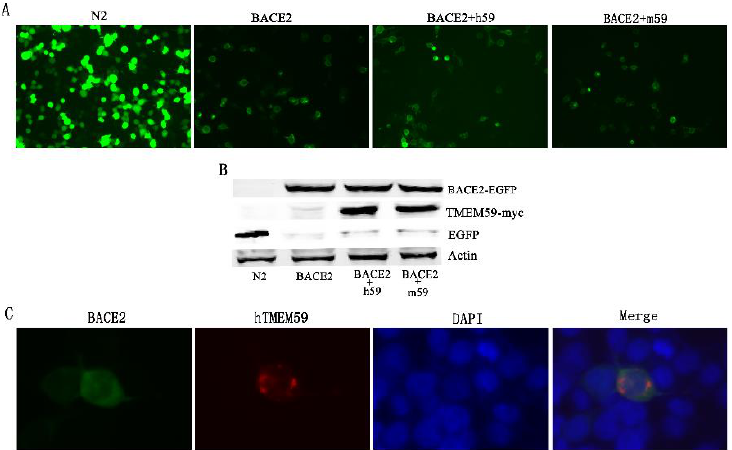
Figure 6. TMEM59 does not affect BACE2 protein expression. ( A ) TMEM59 did not change the localization of BACE2 in HEK293T cells. ( B ) The BACE2 protein level was not affected by TMEM59 in HEK293T cells. ( C ) TMEM59 and BACE2 showed no obvious colocalization in the cytoplasm. 3.5. Expression and Localization of GDI1 and GDI2 Were Changed by TMEM59 HEK293T cells were transiently co-transfected with GDI1/GDI2, and TMEM59 that showed fluorescence intensity was distinguished, as the cell tended to become round.